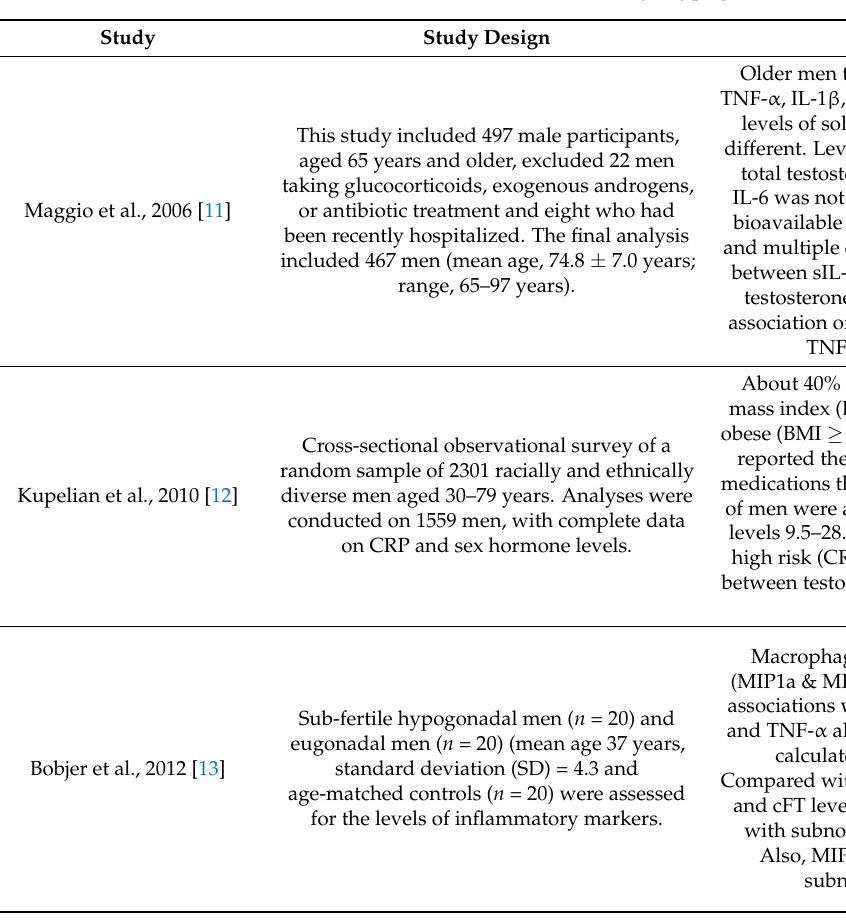
Table 1. Effects of testosterone deficiency (hypogonadism) on the expression and/or function of inflammatory